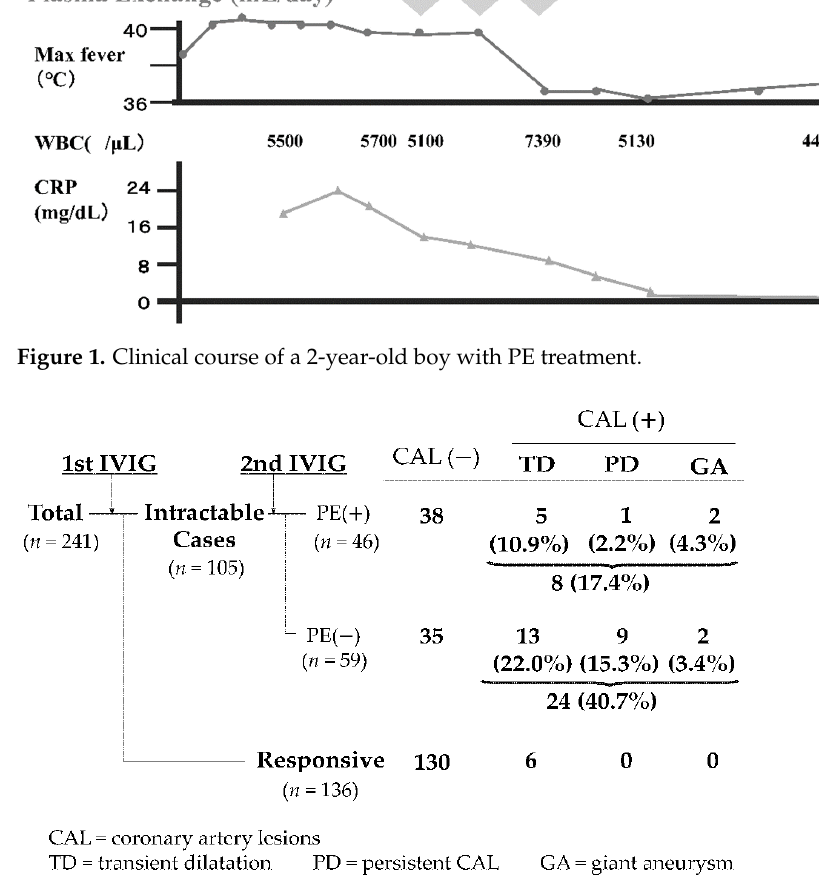
Figure 2. Preventive effect of PE on CALs in IVIG-refractory patients. Table 5. PE therapy significantly reduced the incidence of CALs.